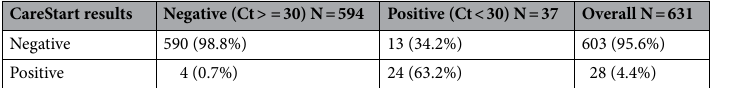
CareStart results